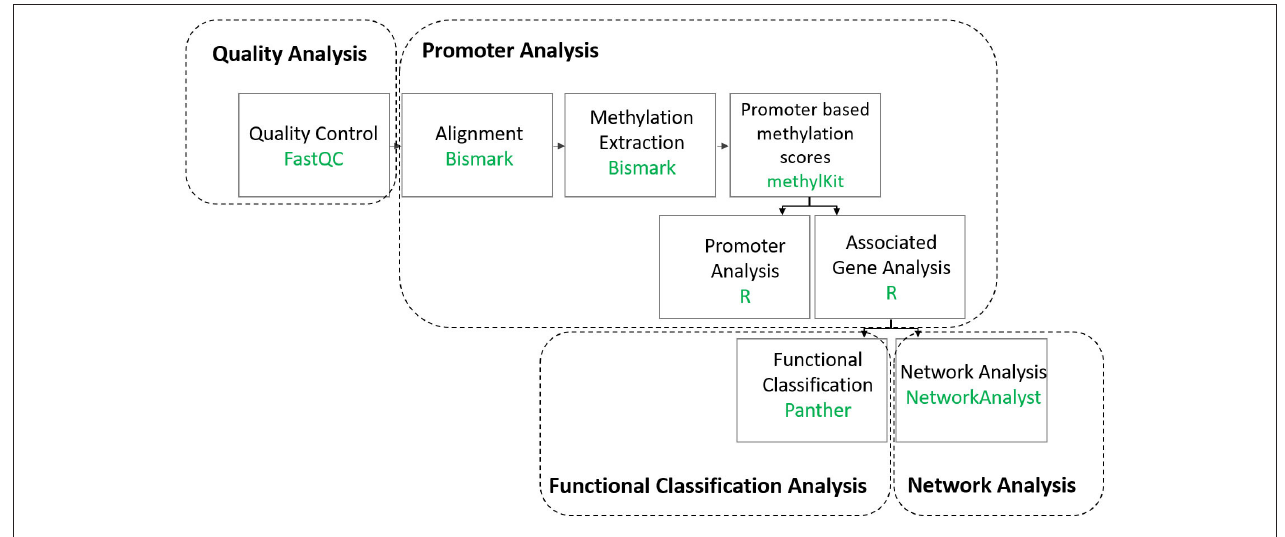
FIGURE 1 | Summary of the data analysis